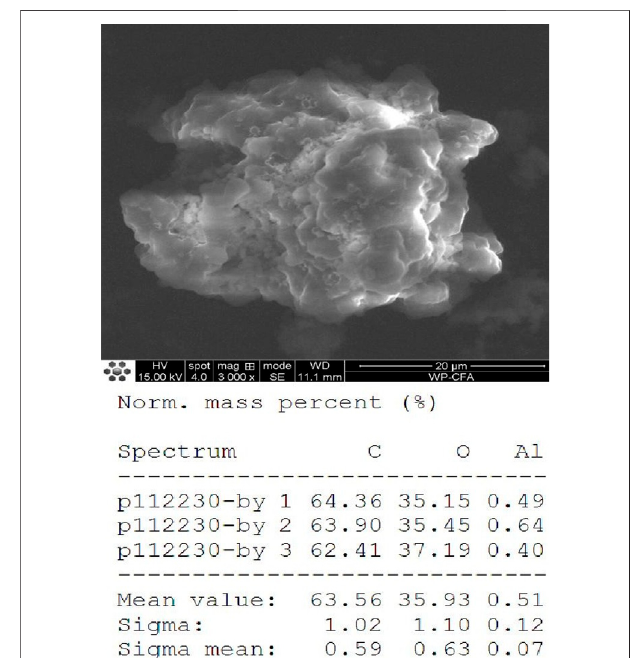
FIGURE 4 | Scanning electron microscopy observation of PHB extract from SS.